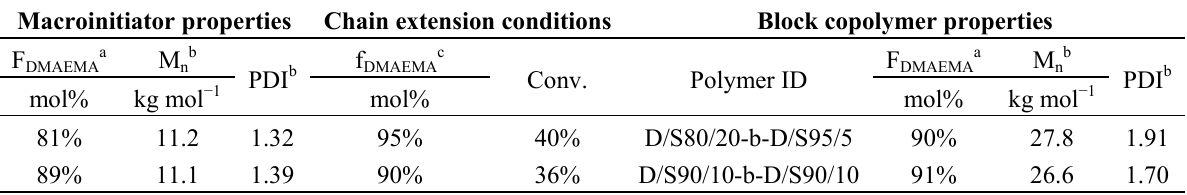
Table 4. Summary of the experimental results and polymer properties in the chain extension experiments at 80 °C in